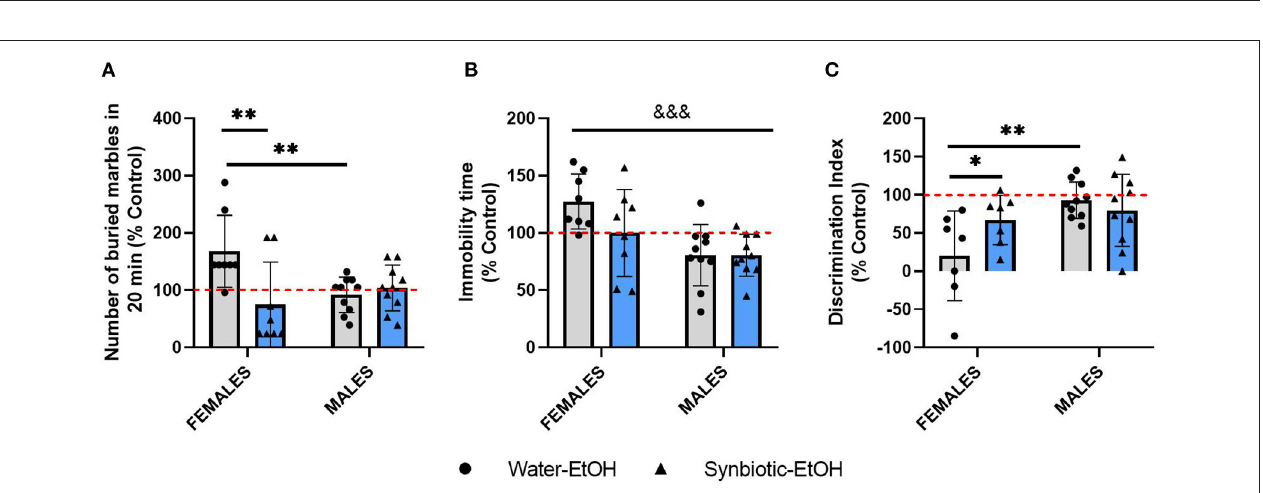
FIGURE 4 | Behavioral alterations following alcohol deprivation in female and male mice exposed to water-alcohol (gray bars and round symbols), or synbiotic-alcohol (blue bars and triangular symbols). (A) In the marble burying (MB) test, females in the water-alcohol group showed an anxiogenic-related effect (increased marble-burying) as compared with control mice, and this effect was prevented in the synbiotic-alcohol group ( p < 0.01). Also, female mice in the water-alcohol group showed more anxiogenic-like behavior than males ( p < 0.01). (B) In the tail suspension (TS) test, females showed more depressive-like behavior (increased immobility) than males ( p < 0.001). (C) In the novel object recognition (NOR) test, females in the water-alcohol group showed deficits in long-term recognition memory (decreased discrimination index scores), but not males ( p < 0.01), and the deficits observed in females in the water-alcohol group were abolished in the synbiotic-alcohol group ( p < 0.05). &&& p < 0.001 (main effect of sex); * p < 0.05, ** p < 0.01 (LSD post-hoc test following significant interaction in two-way ANOVA).